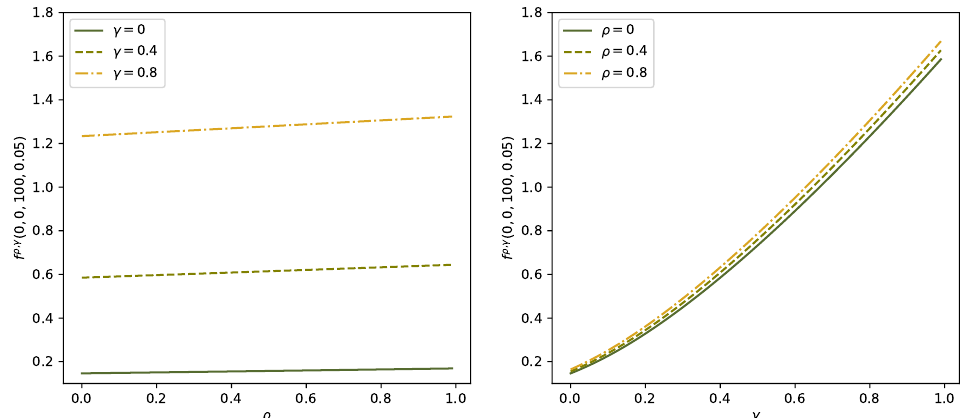
Figure 3. Solution f ρ , γ ( 0, l , λ , (cid:96) ) for l = 0, λ = 100, varying (cid:96) ∈ [ 0,0.05 ] and different levels of γ and ρ with computed with the DNN-algorithm. We have ρ = 0 ( left ) resp. γ = 0 ( right ).